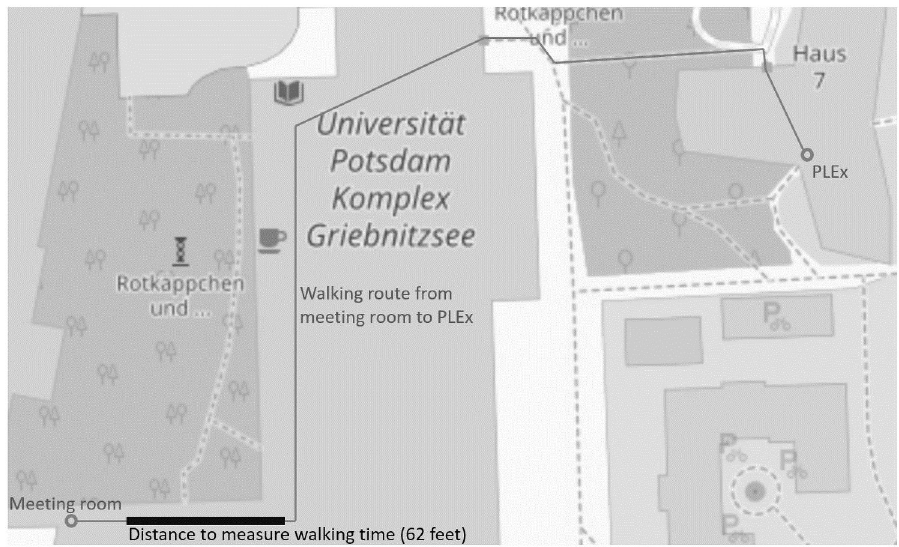
Fig 1. Location of the experiment. Reprinted from OpenStreetMap (https://www.openstreetmap.org/map=18/52. 39302/13.12775) under the Creative Commons Attribution License (CC BY 4.0), with permission from © OpenStreetMap Contributers